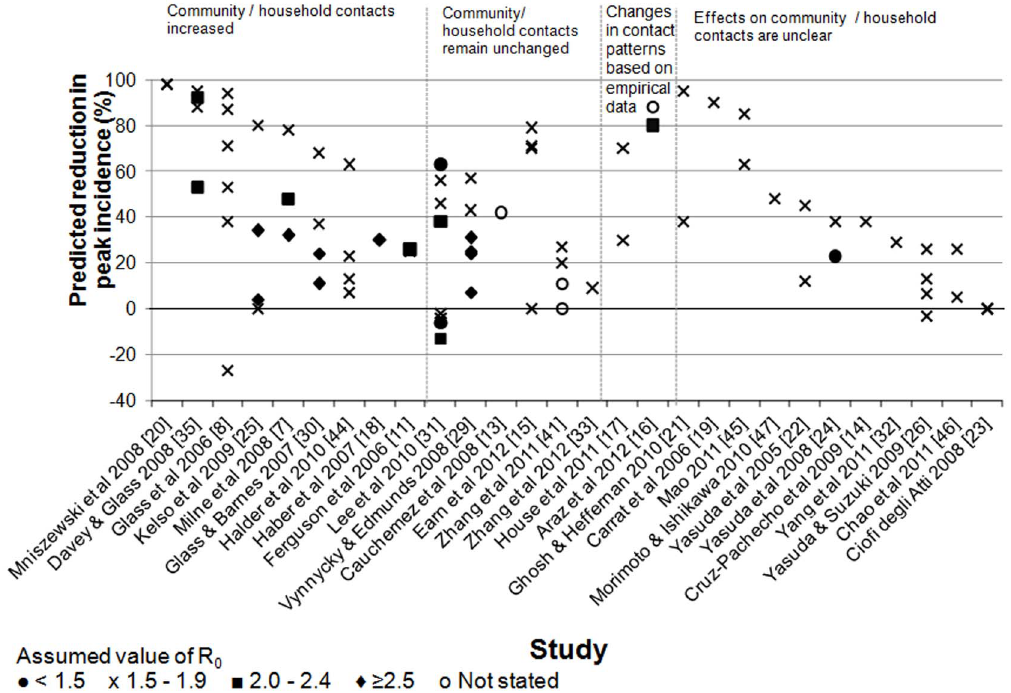
Figure 1. Summary of the estimated effects of school closures on peak incidence of pandemic influenza (all ages) predicted by the modelling studies. Different symbols are used to reflect the assumed value for R 0 . The findings are grouped according to whether they assumed that the community/household contacts increased, remained unchanged, the assumptions about contact were based on empirical data or were unclear. Some studies assumed that workplaces and/or other public places also closed [11,14,23]. All studies that stated their assumptions regarding the effects of school closure on contact patterns assumed that contacts between school-aged children were reduced or eliminated.